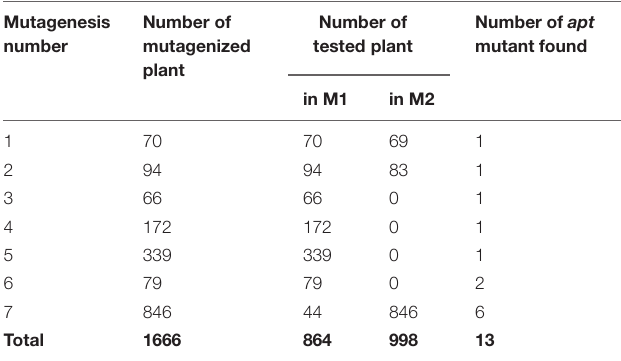
TABLE 1 | Number of tested plants and number of apt mutants